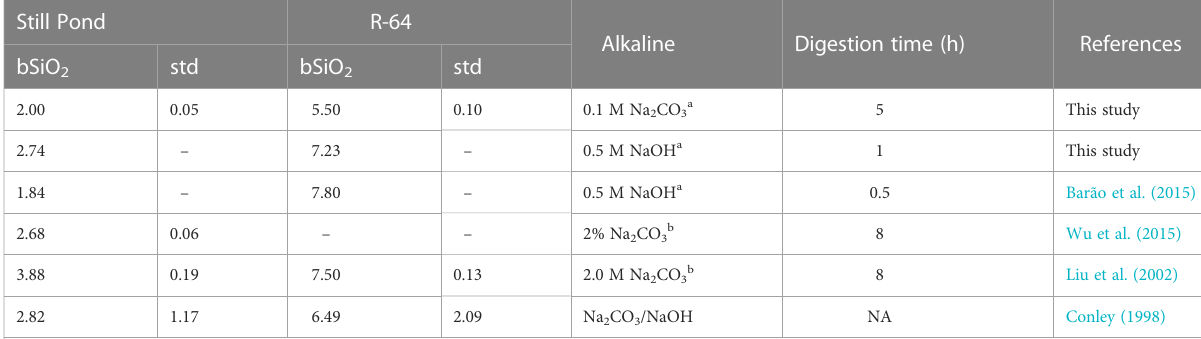
TABLE 2 The bSiO 2 % of interlaboratory comparison sediment samples (Still Pond and R-64). The location of the two samples is described in Conley